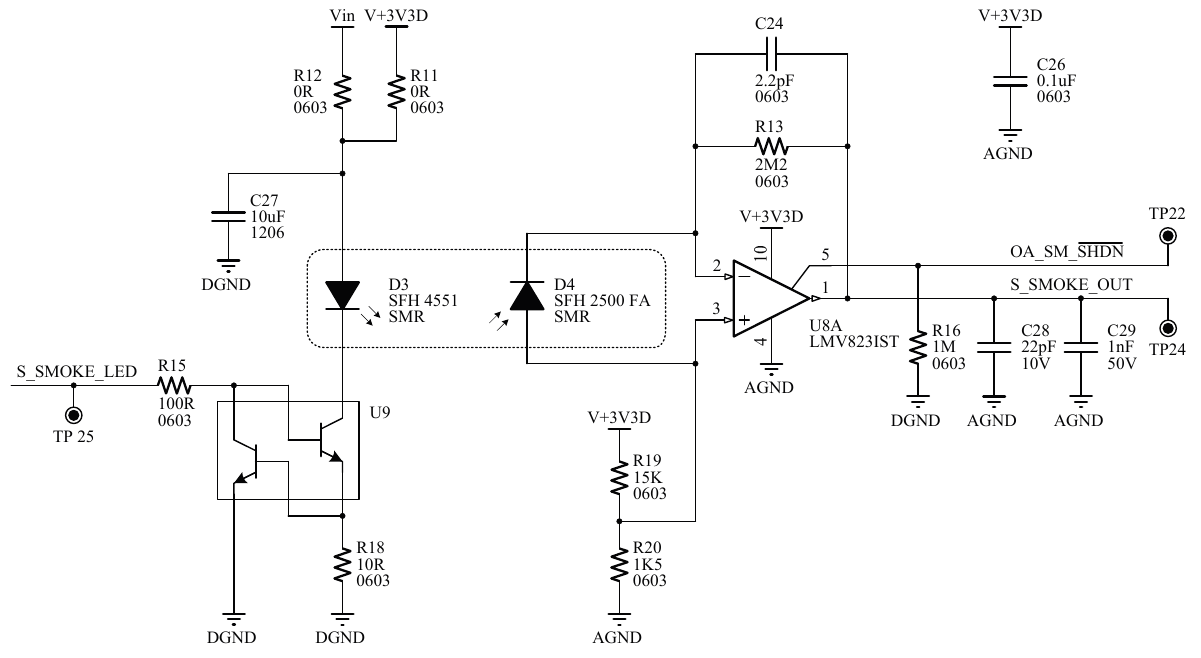
Figure 3. Signal-conditioning interface of the smoke sensor.